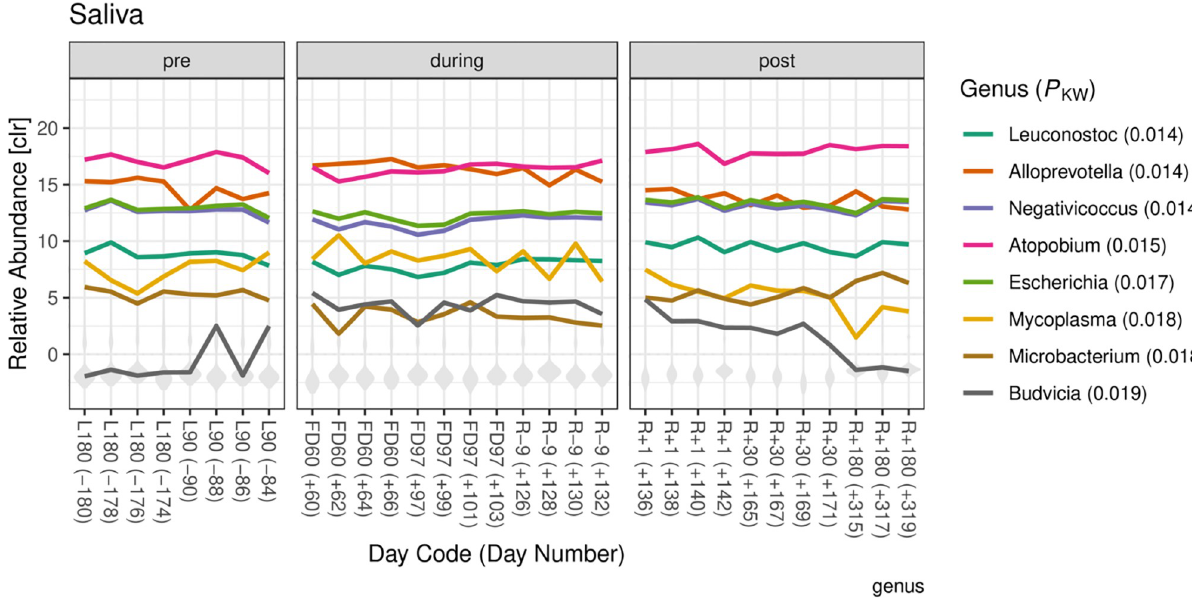
Fig 3. Relative abundances of genera that were differentially abundant among flight state in saliva samples. The relative abundances of the eight genera with the smallest Kruskall-Wallis P -values are shown in color. The distribution of relative abundances from other genera are shown in grey. Abundances are log transformed and relative to the geometric mean abundance per sample using genera that were present within each flight state (centered log-ratio